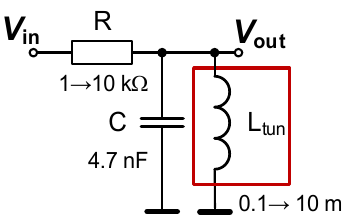
Figure 11. Electronically tunable LC band-pass filter.